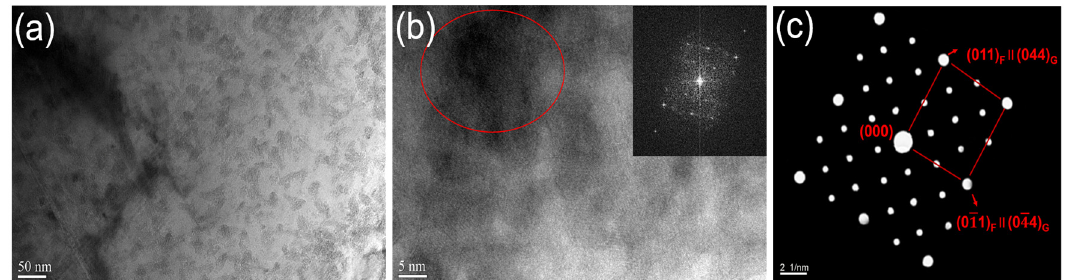
Figure 7. An HRTEM image of a ferrite phase ( a ); and an area electron diffraction pattern ( b ) and the corresponding FFT pattern ( c ) of Z3CN20-09M stainless steel after 15,000 h of aging. The red circles are G phase. The inset figure corresponds to the SEAD in (b).